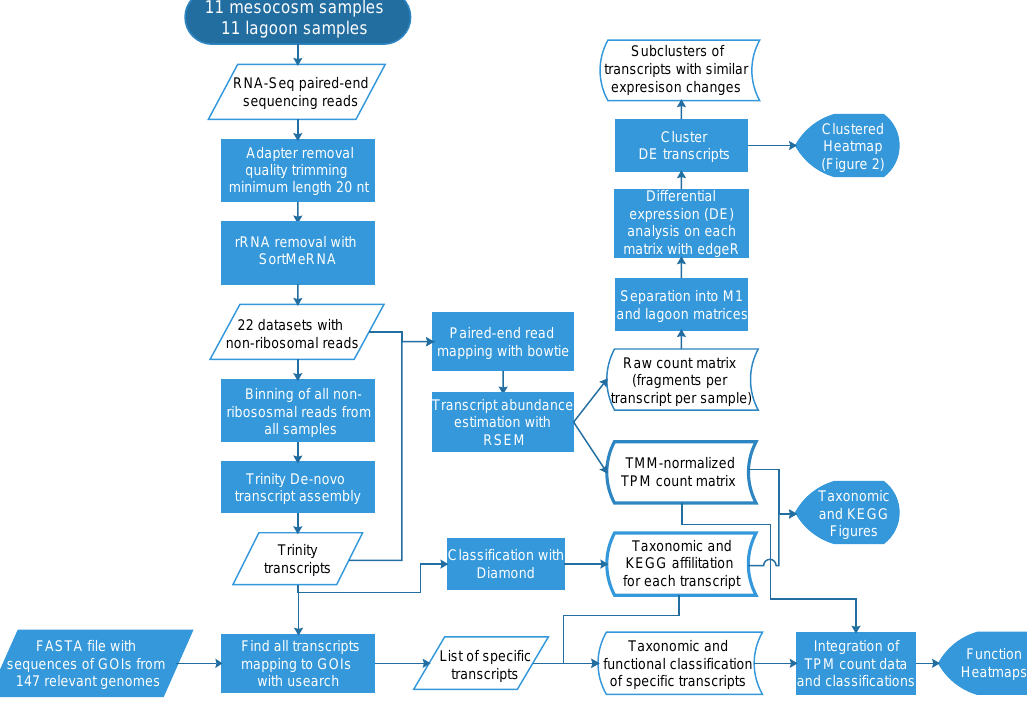
Figure 1. Flowchart describing the major steps in the bioinformatics workflow. Preprocessing of RNA-Seq reads was done separately for each data set, leading to 22 data sets of nonribosomal paired-end reads. These were binned and used as input for de-novo assembly of transcripts. The nonribosomal reads were mapped back onto the assembled transcripts with bowtie (Langmead, 2010) to infer each transcripts abundance in each sample using RSEM (Li and Dewey, 2011). Raw abundances were used for differential expression (DE) analysis and cluster analysis with edgeR on the M1 and lagoon count matrices separately, to find transcripts which changed significantly over time. To enable direct in-between sample comparison of transcript abundances, raw abundances were converted to TPM (transcripts per kilobase million) and TMM normalized (trimmed mean of M values) in RSEM, creating the final count matrix used for all figures showing transcript abundances. Classifications for these transcripts were generated using Diamond (Buchfink et al., 2015) against the RefSeq protein database. Further, a manually curated list with specific genes involved in N and P metabolism, as well as light utilization (genes of interest, GOIs) was used to extract the corresponding transcripts, but final classifications were inferred from the Diamond output. This information was used to produce the integrated function-per-taxon heat